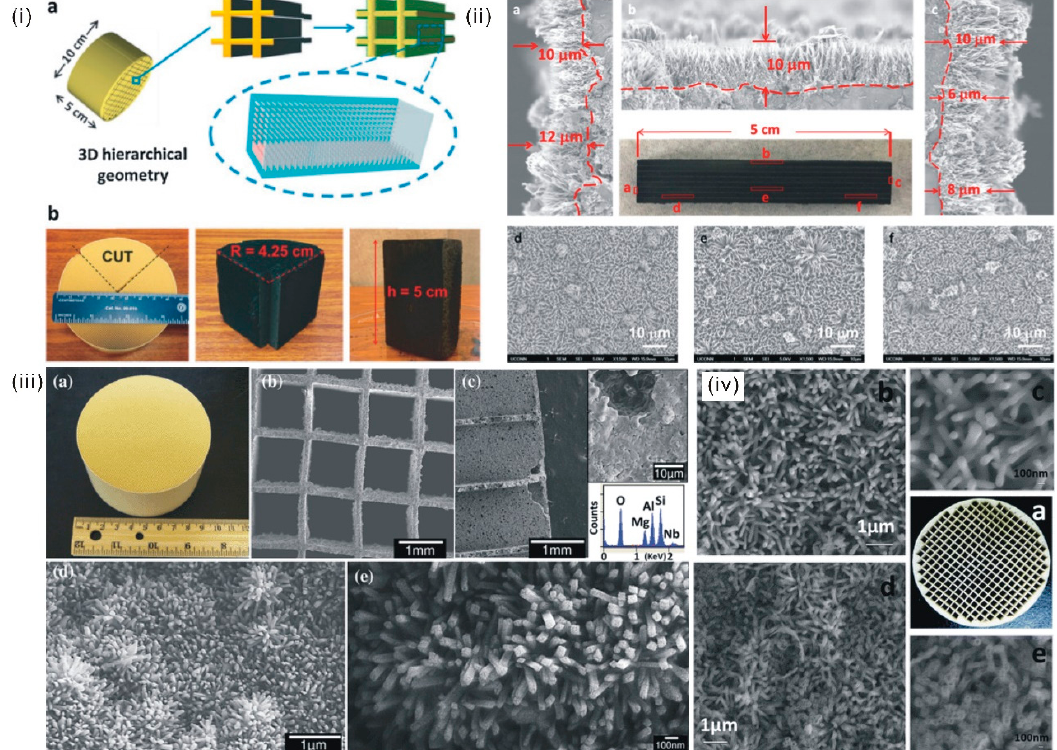
Figure 3. ( i ) ( a ) Monolithic integration of nano-arrays on commercialized honeycomb supports. ( b ) Dimensions of a typical piece of a monolithic nano-array catalyst; ( ii ) SEM images of the nano-arrays grown inside the monolithic honeycomb channels. ( a – c ) Cross-sectional views and (d–f) top views of Co 3 O 4 nano-arrays; ( iii ) ( a ) Top-view optical and ( b ) SEM images of the honeycomb monolith. ( c ) Side-view SEM images of the honeycomb monolith and the corresponding Energy-dispersive X-ray (EDX) spectrum. ( d , e ) SEM images of TiO 2 nanorod arrays grown on the 3D honeycomb monolith; ( iv ) ( a ) Photograph of a 3D cordierite honeycomb substrate. SEM images of ( b , c ) CeO 2 –ZnO composite nano-arrays before removing the ZnO template and ( d , e ) CeO 2 nanotube arrays after removing